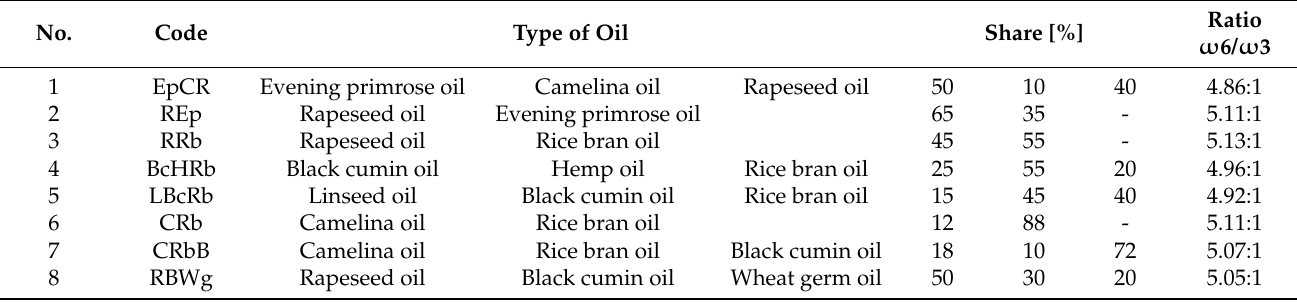
Table 1. Composition of oil